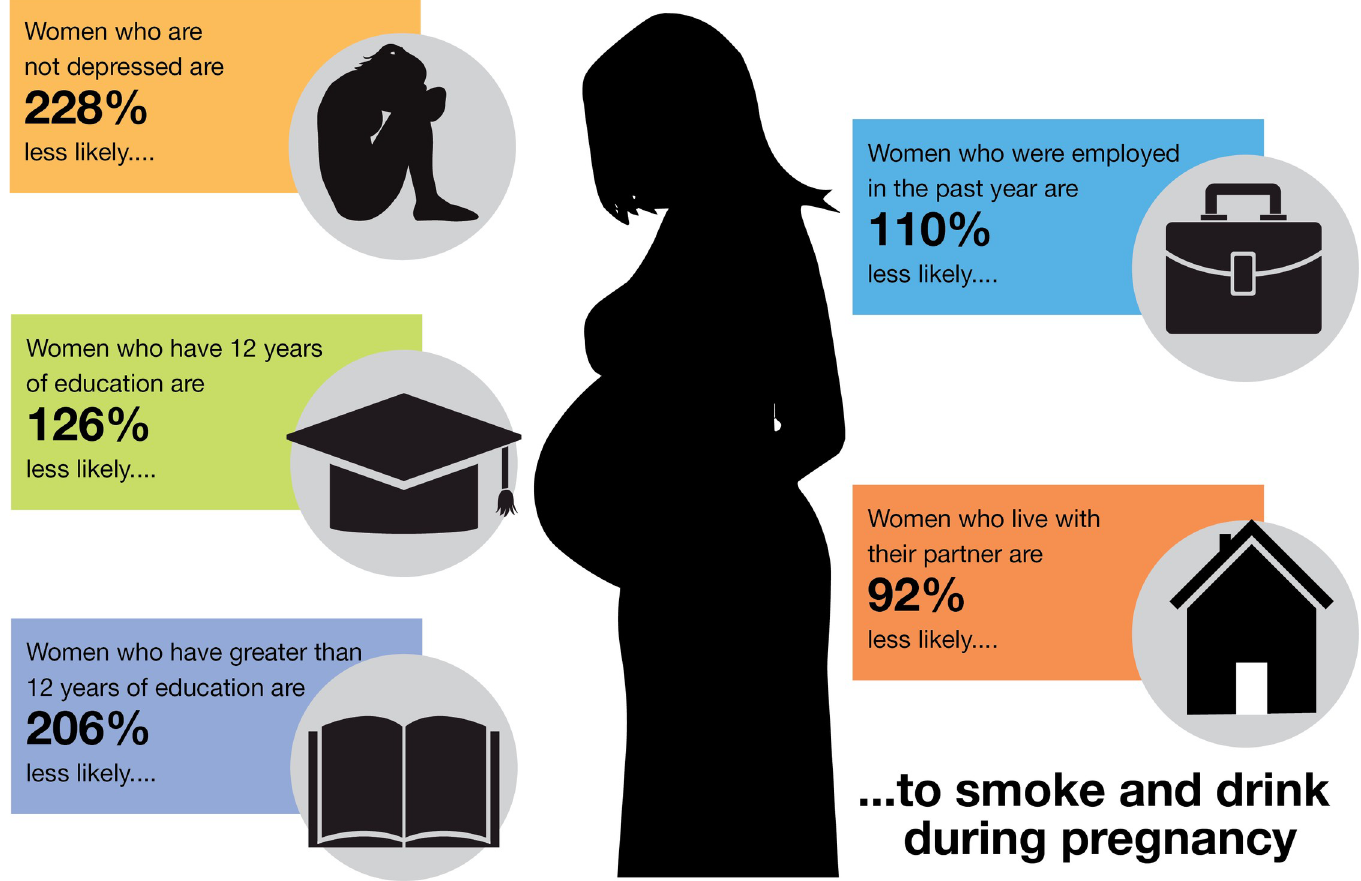
Fig 3. Protective factors–what factors protect against smoking and drinking during pregnancy?. The five maternal factors which were associated with decreased risk for both smoking and drinking during pregnancy.